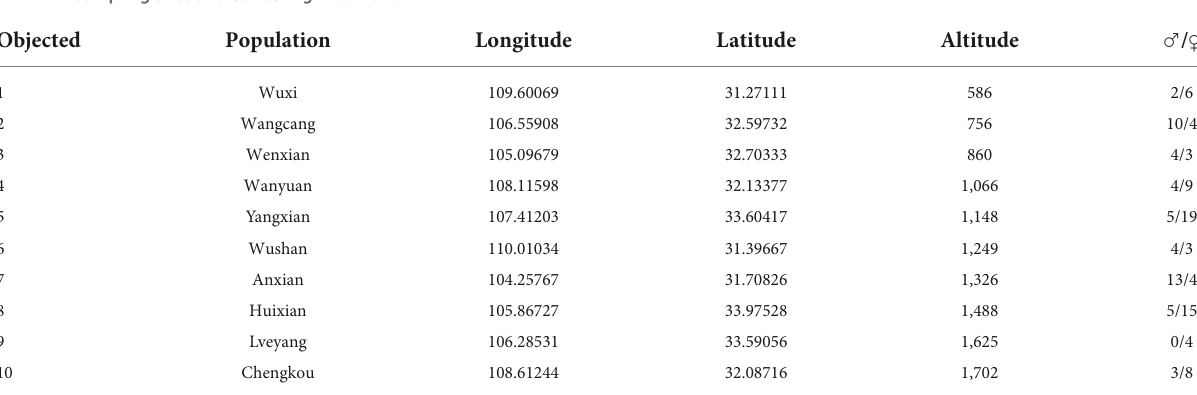
TABLE 1 Sampling sites and collecting